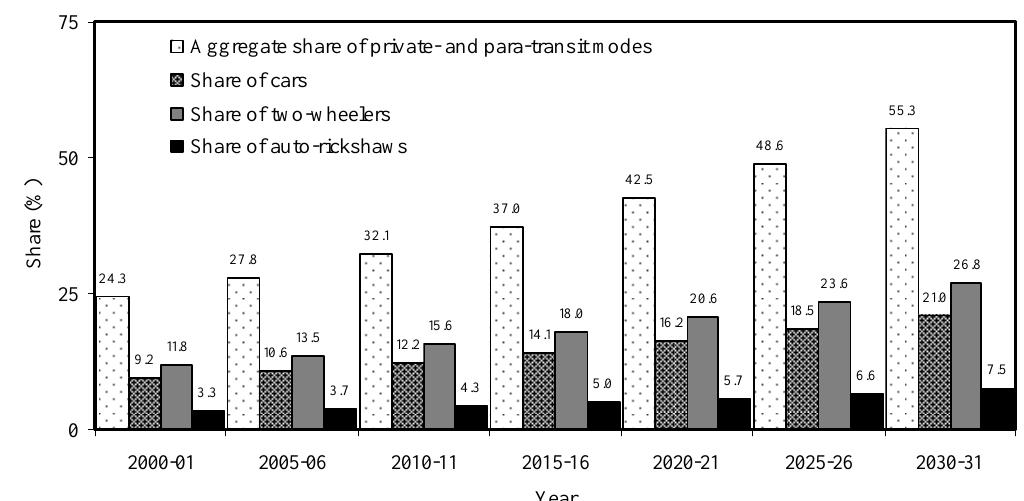
Figure 4. Projected share of private- and para-transit modes (cars, two-wheelers, and auto- rickshaws) during the next three